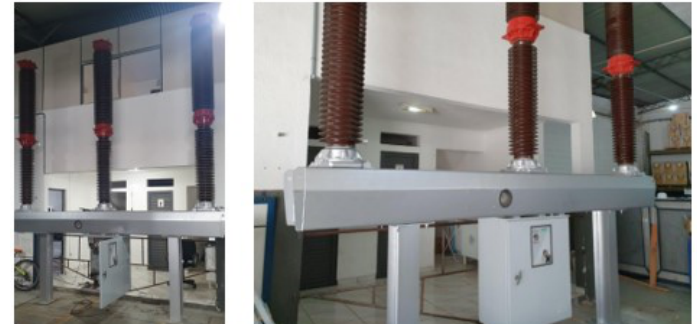
Figure 2. CGL 312 test circuit breaker.